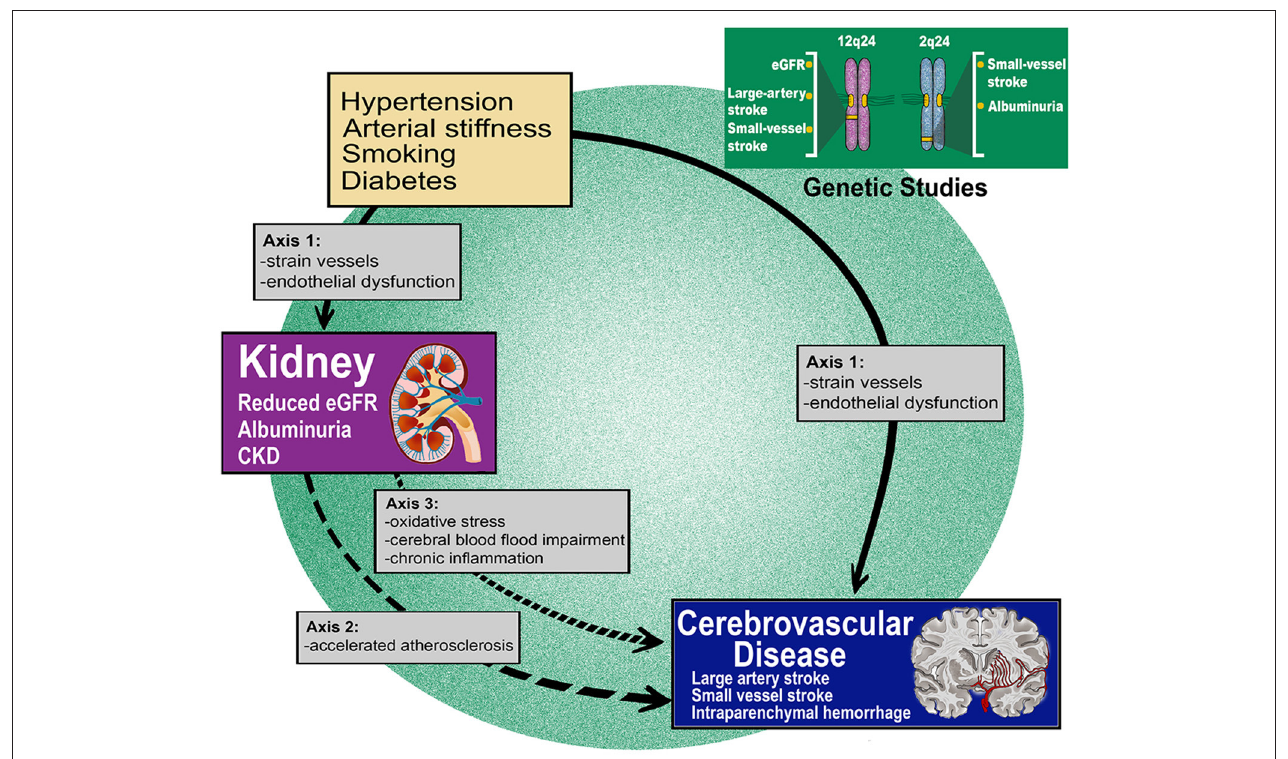
FIGURE 1 | Renal dysfunction is robustly associated with acute and chronic forms of cerebrovascular disease. Mechanisms through which renal dysfunction leads to cerebral small vessel disease and other cerebrovascular events can be summarized in three axes. Genetic epidemiology findings reinforce the causality of the highlighted